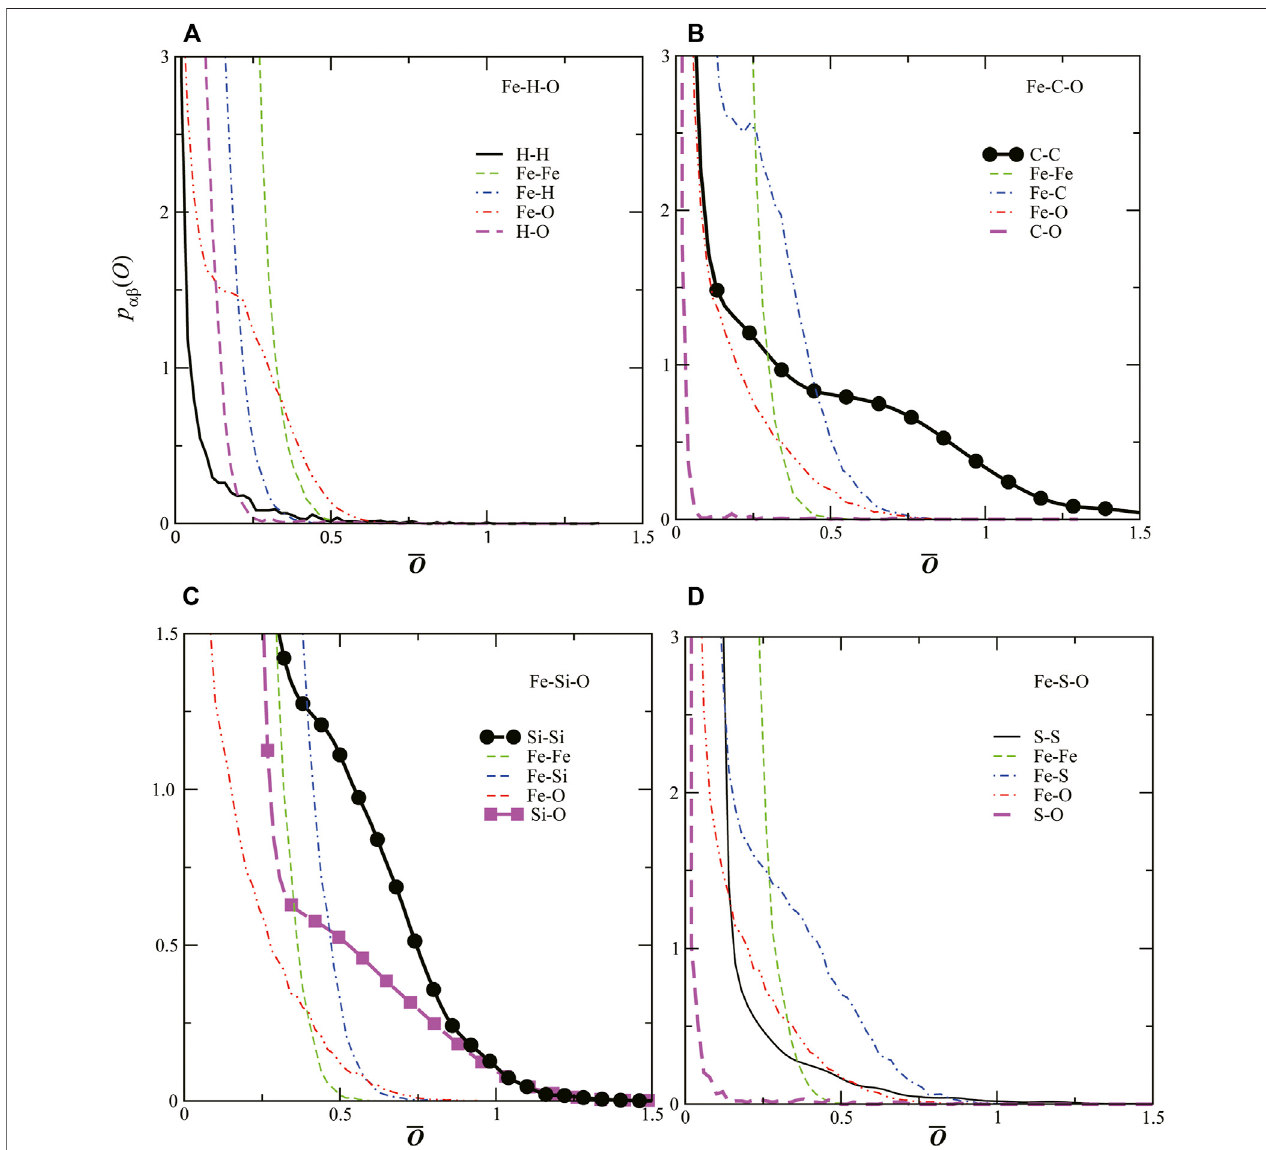
FIGURE3 | Distributions p αβ ( (cid:1) O ) ofthe overlap populations Oij for fi ve pairs of α – atomic and β – atomic types ofliquids (A) Fe-H-O, (B) Fe-C-O, (C) Fe-Si-O and (D) Fe-S-O. Thick solid, thin dashed, dotted dashed, double – dotted dashed and thick dased lines show p αβ ( (cid:1) O ) for LE – LE, Fe – Fe, Fe – LE, Fe – O and LE – O, respectively. Circles in Fe – C – O (B) and Fe – Si – O (C) show p C – C ( (cid:1) O ) and pSi – Si ( (cid:1) O ) , respectively. Squares show pSi – O ( (cid:1) O ) in liquid Fe – Si – O.